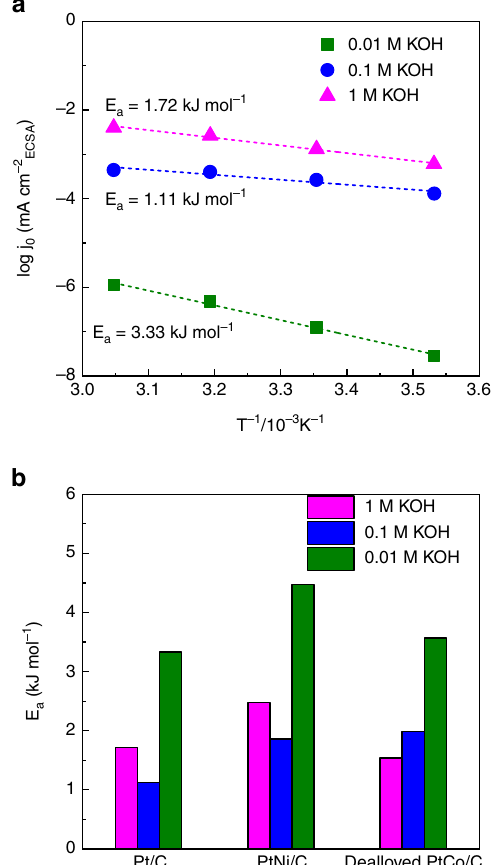
Fig. 5 HER energy barrier for various nanostructured electrocatalysts. a The relationship between the temperature and the catalytic activity of Pt/C under certain temperature range (10 – 55 °C). b A comparison of the activation energy ( E a ) for a series of different Pt-based nanostructured electrocatalysts in different alkaline